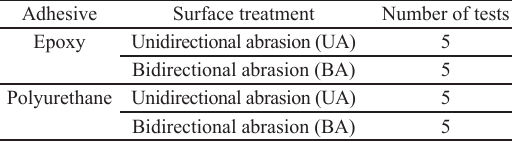
Table 1. Test matrix.